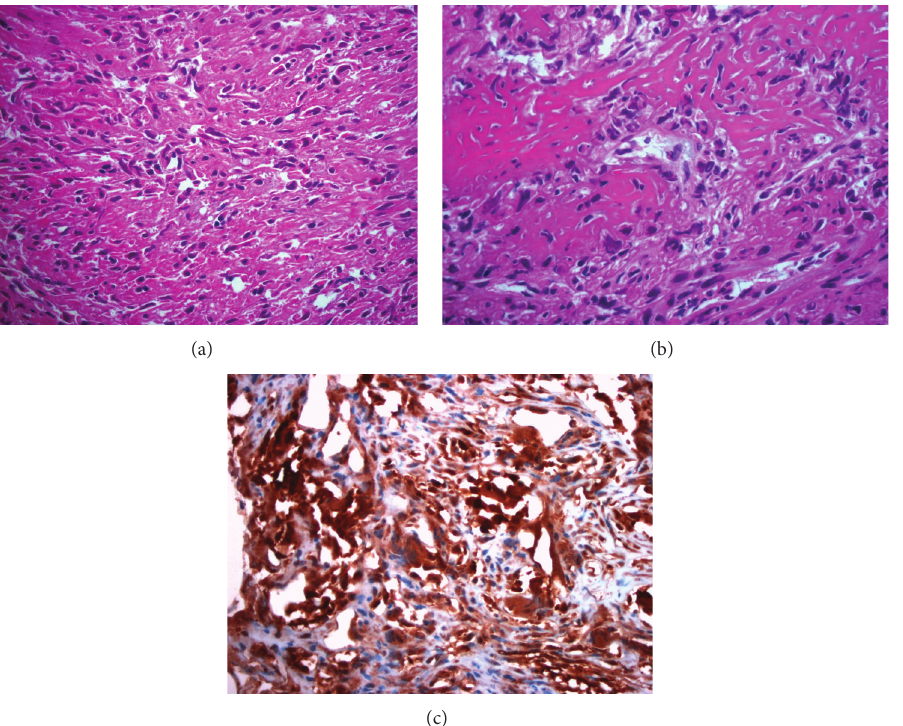
Figure 2: Osteosarcoma of pelvis demonstrating hyperchromatic spindle-shaped tumor cells associated with matrix production (a) and osteoid formation (b). Tumor stains positive for 𝛽 -hCG (c) (Hematoxylin-eosin [a, b], original magnifications × 4 [c], × 20